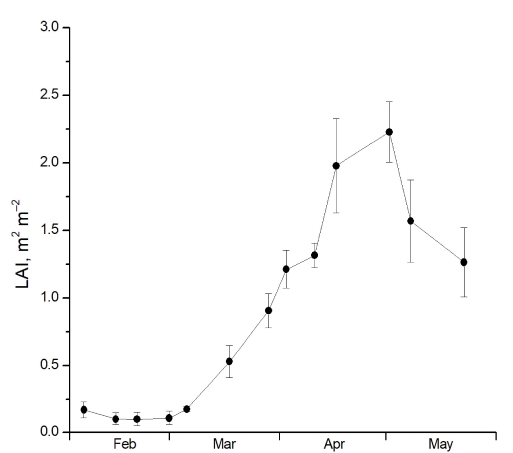
per plot) ± standard